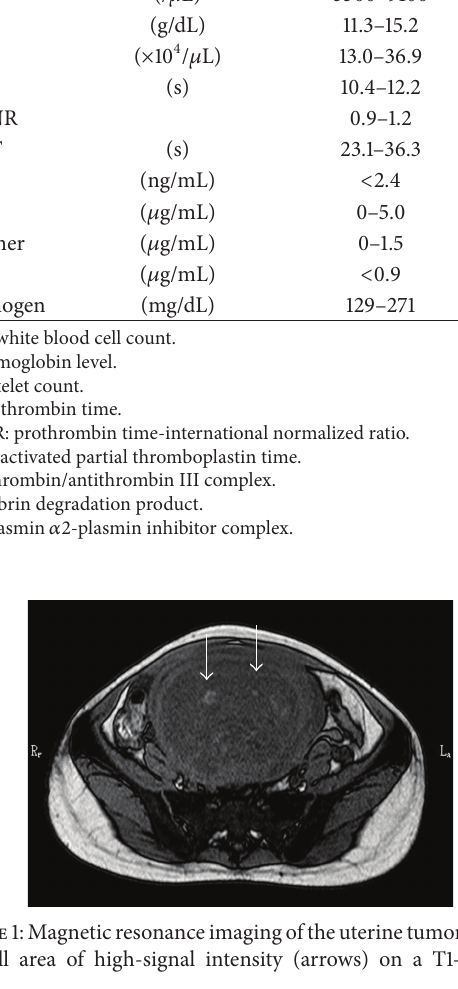
Figure 2: Magnetic resonance imaging of the uterine tumor show- ing heterogeneous high-signal intensity (arrows) on a T2-weighted image.